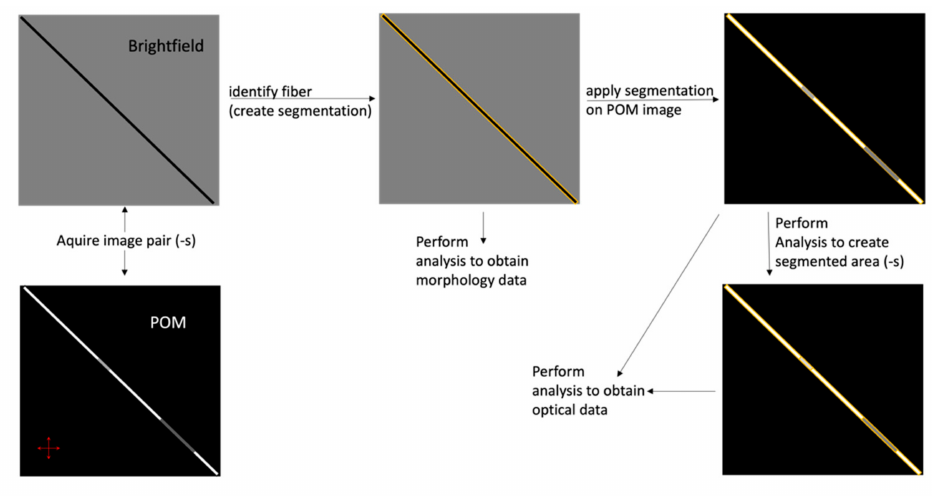
Scheme 1. Schematic drawing of the workflow for the semi-automated image analysis